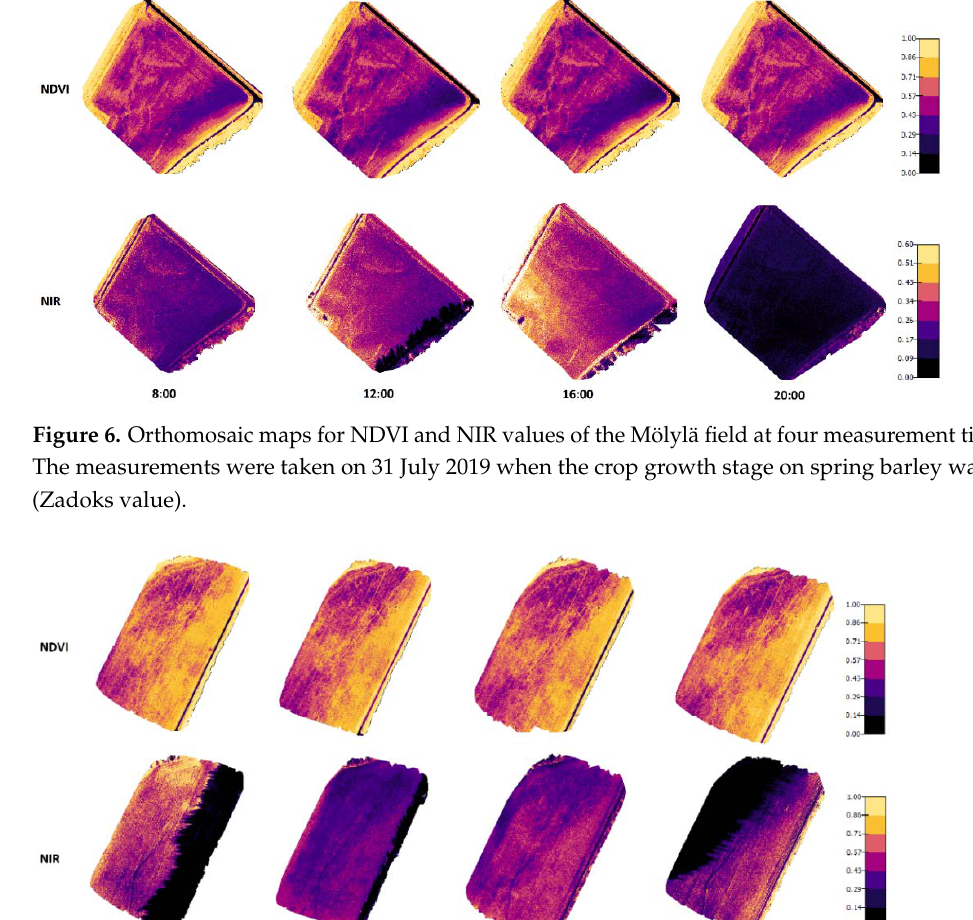
Figure 8. NIR and NDVI development on Koirasuo field during the growing season in 2020. The Zadoks values were 69 (28.6), 83 (15.7), and 86 (1.8). The orthomosaic maps were created from pic ‐ tures taken at 12:00.